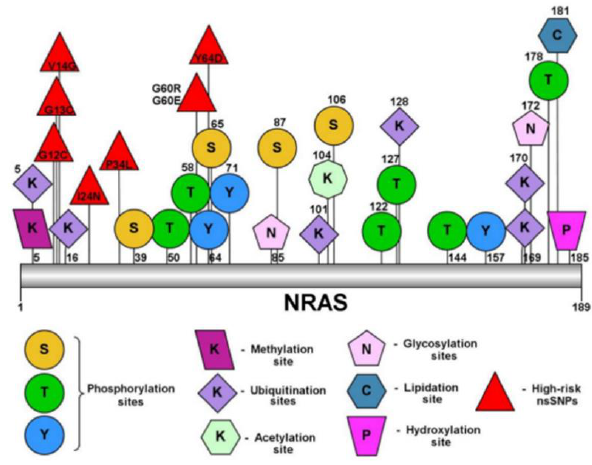
Figure 1. Putative PTM sites of high-risk nsSNPs of NRAS protein. 2.3. Protein–Protein Interaction (PPI) and Molecular Network Analysis PPI showed that NRAS interacts with RAF1, BRAF, NF1, PTPN11, PIK3CA, HRAS, EGFR, KRAS, MAPK3, and SOS1 proteins (Figure 2a). Molecular networks showed that the NRAS gene is involved in MAPK cascade pathways involving apoptosis, cell growth, cell proliferation and cell cycle (Figure 2b).